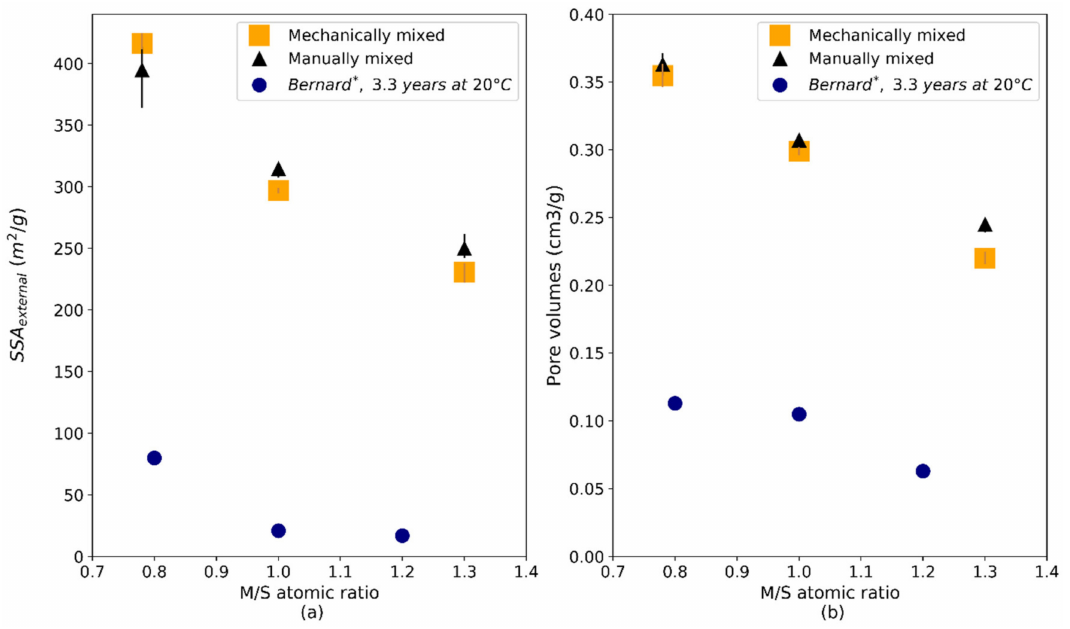
Figure 14. SSA ext ( a ) and pore volumes ( b ) obtained by t-plot in M-S-H pastes as a function of the M/S atomic ratio and of the mixing protocol. * Bernard et al. measurements (in blue) correspond to M-S-H powders equilibrated for 3.3 years at 20 ◦ C.